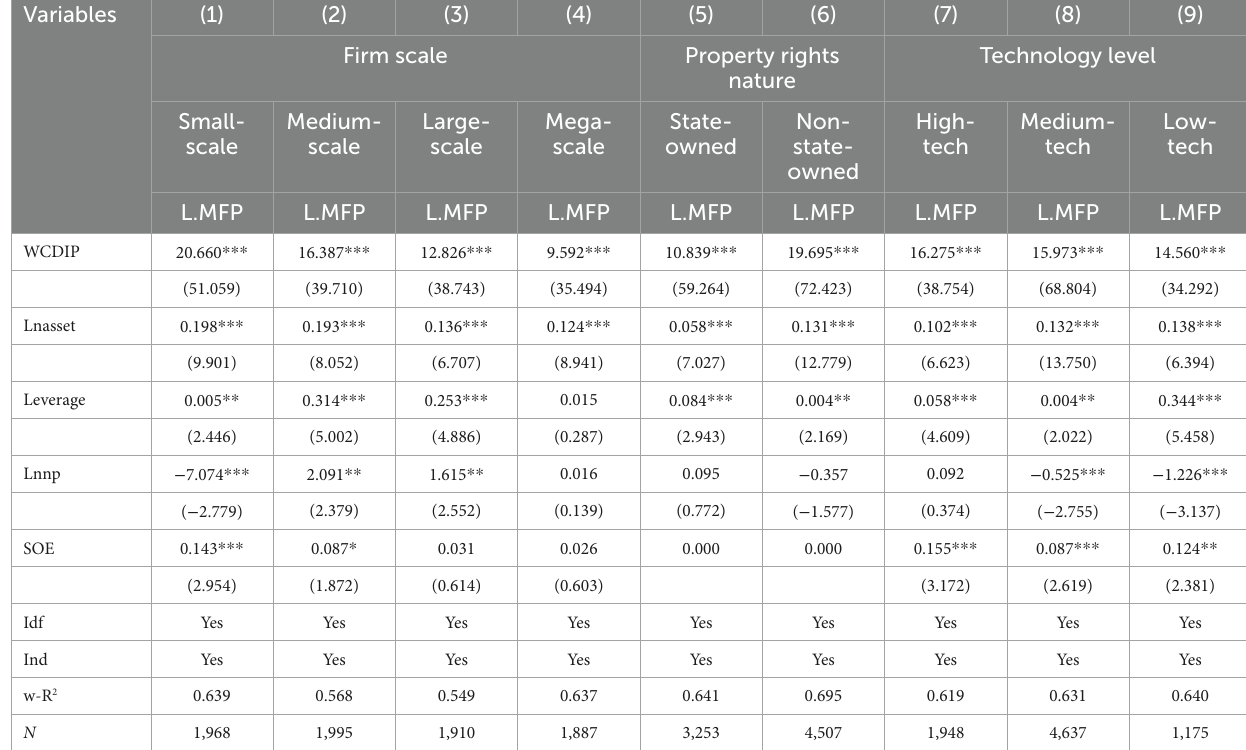
TABLE 6 Robustness test of the heterogeneity impact of WCDIP on